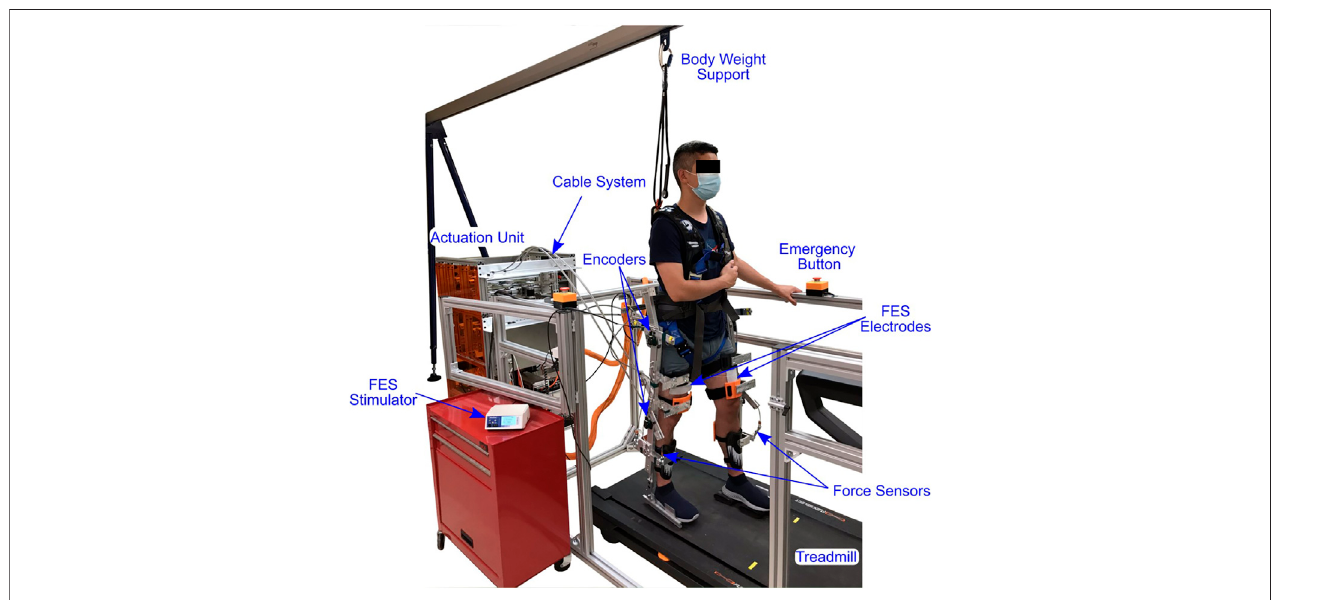
FIGURE 5 | The exoskeleton testbed used for treadmill walking. The exoskeleton uses cables to apply torque at each joint using electric motors installed in the actuation unit. Surface FES is applied on the quadriceps and hamstrings muscle groups. Additional components of the walking system are labeled in the